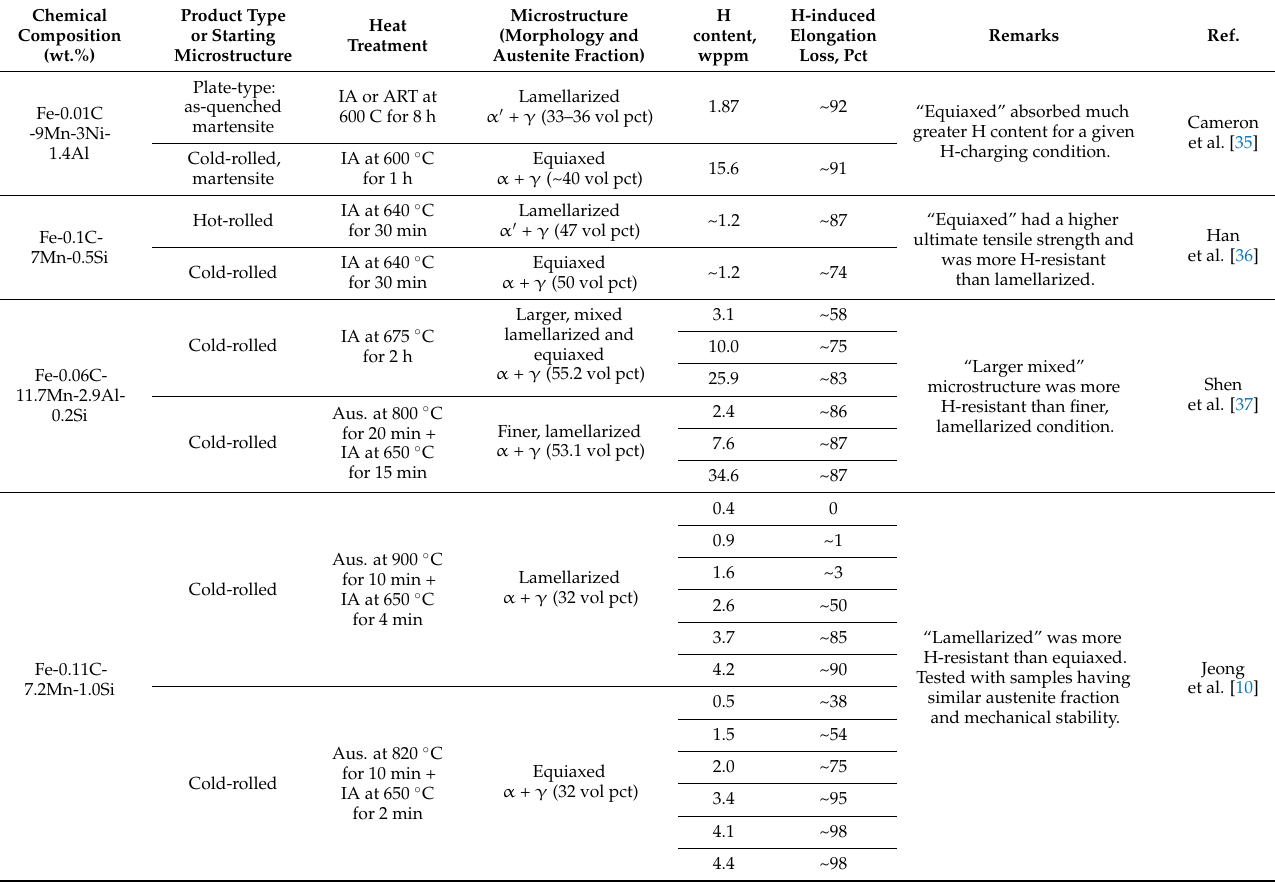
Table 1. Comparison of H-embrittlement (HE) characteristics of lamellarized versus equiaxed microstructures of medium- Mn steel, evaluated by means of slow strain rate testing (SSRT), at room temperature ( α , α –ferrite; α (cid:48) , α (cid:48) –martensite; and γ ,